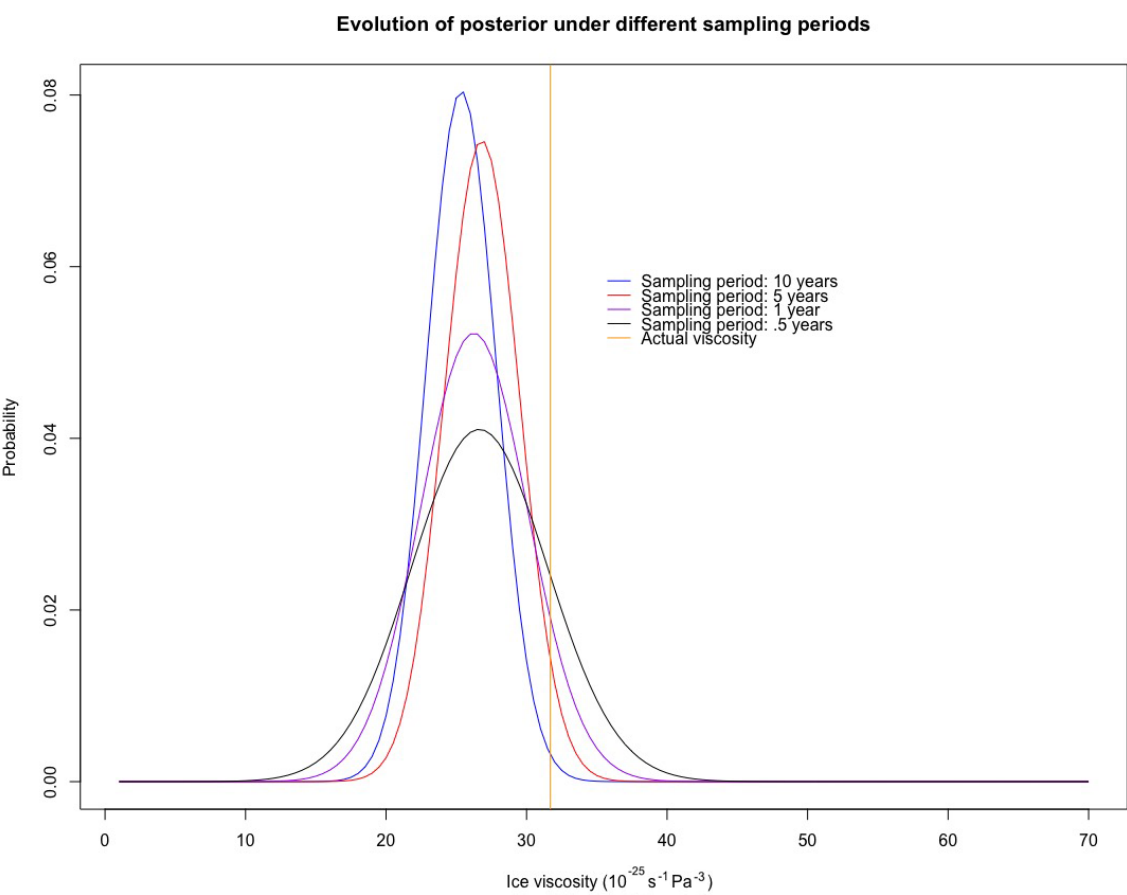
Figure 9. A comparison of posteriors in test case D (i.e., mass balance field producing a periodic SIA solution) under different sampling periods: data sampled once every 10 years, every 5 years, once a year, and twice a year. The general trend is that the posterior tends to become less biased as the period of sampling decreases, although the posterior becomes more diffuse. The University of Iceland Institute of Earth Sciences Glaciology Team takes measurements twice a year for summer and winter mass balance